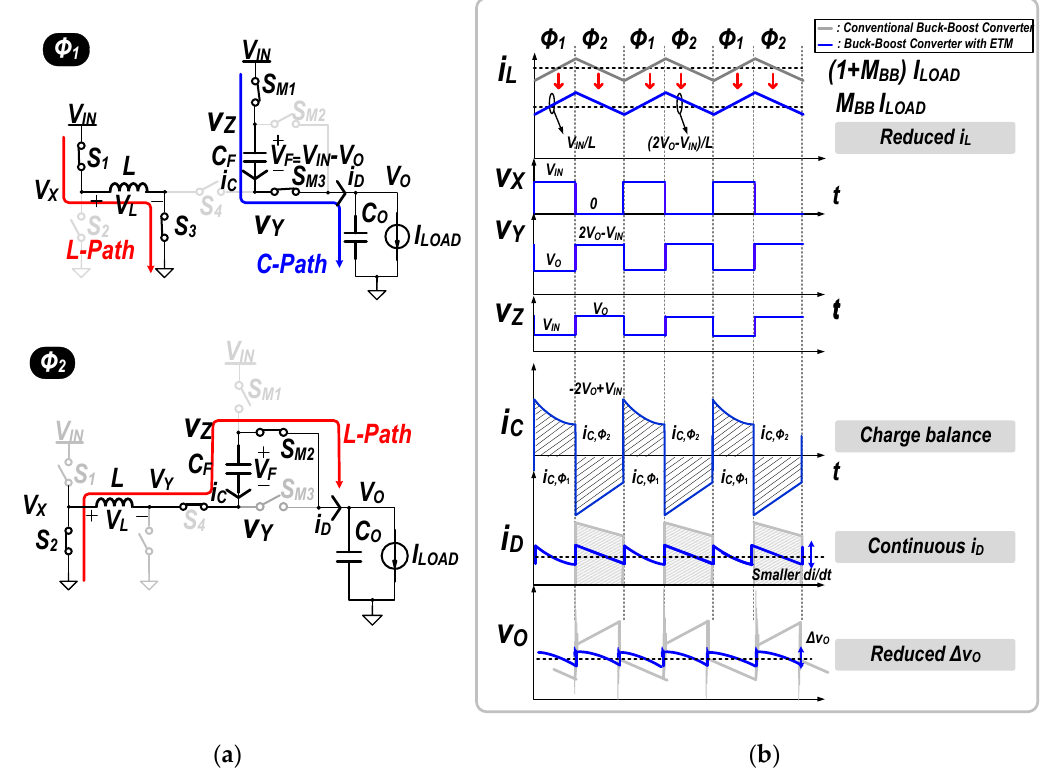
Figure 8. Operating modes ( a ) and waveforms ( b ) of buck-boost converter with ETM.